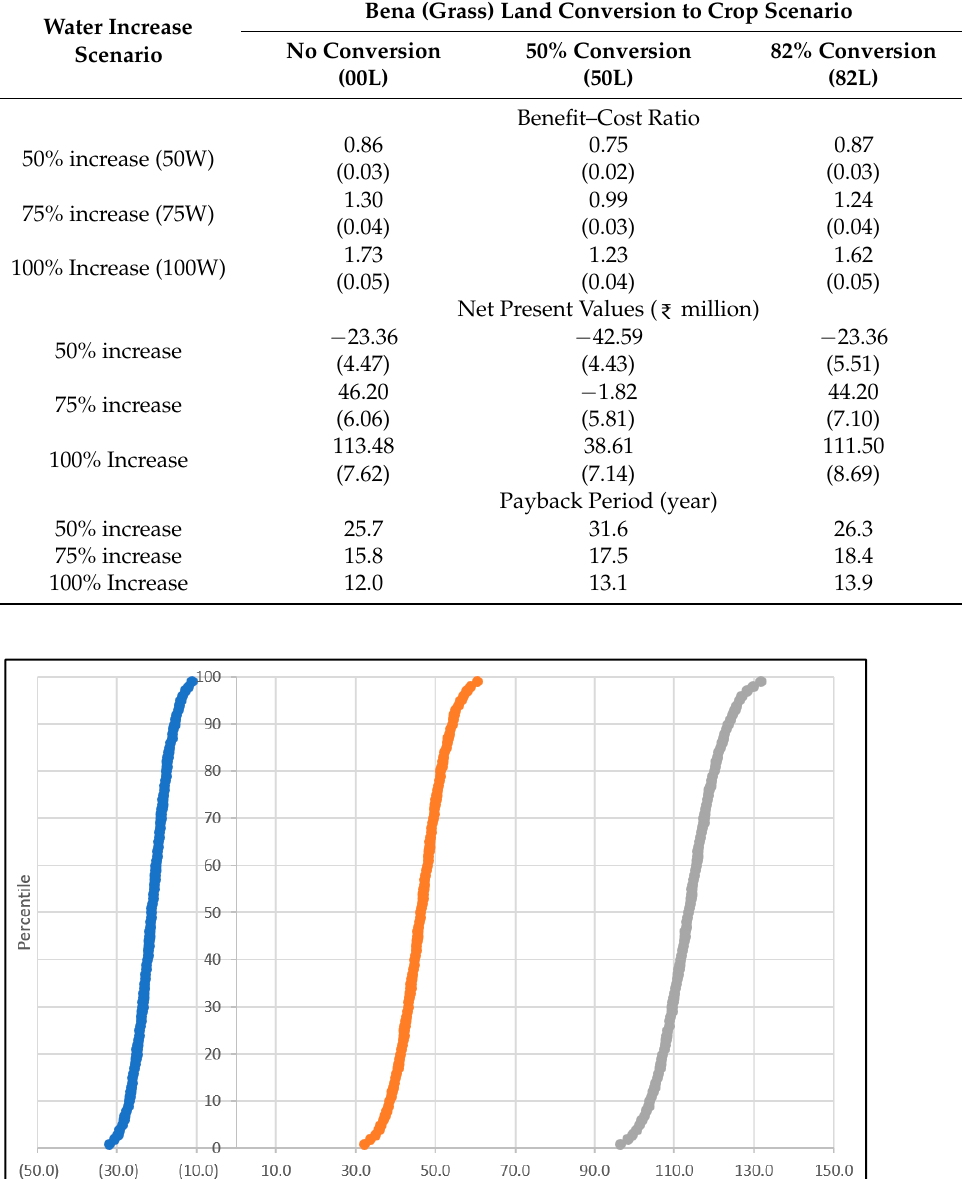
Table 8. Monte Carlo simulation estimates of mean and standard deviation values of Benefit–Cost Ratios, Net Present Values, and Pay-back Period for the lift irrigation scheme under alternative water delivery and land-conversion